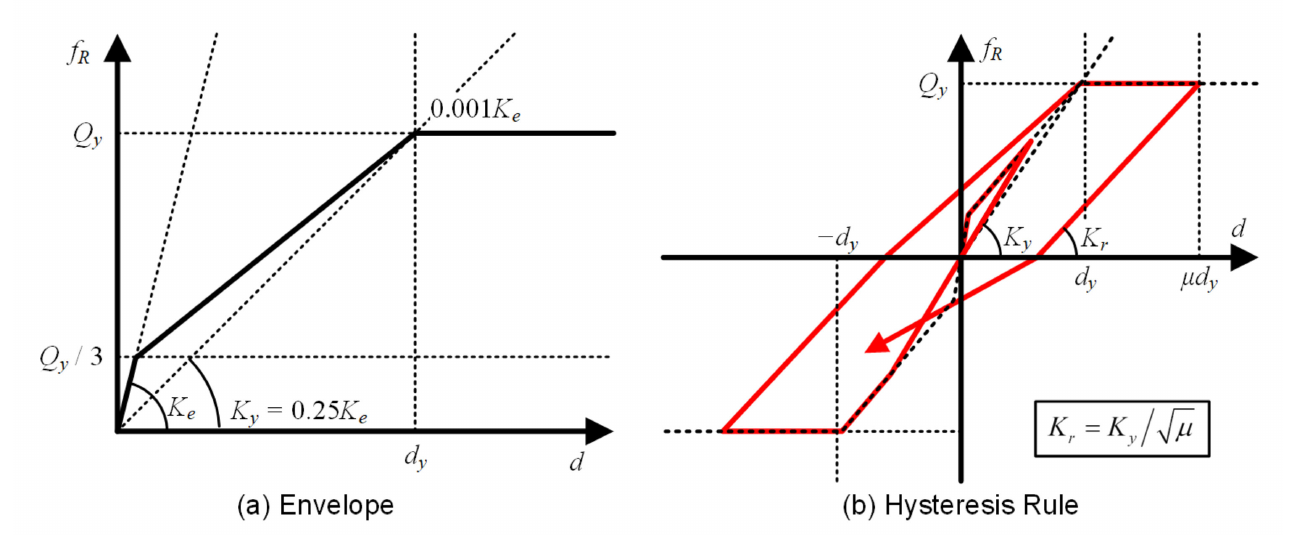
Figure 5. Restoring force–displacement relationship of the nonlinear system: ( a ) envelope; ( b ) hysteresis